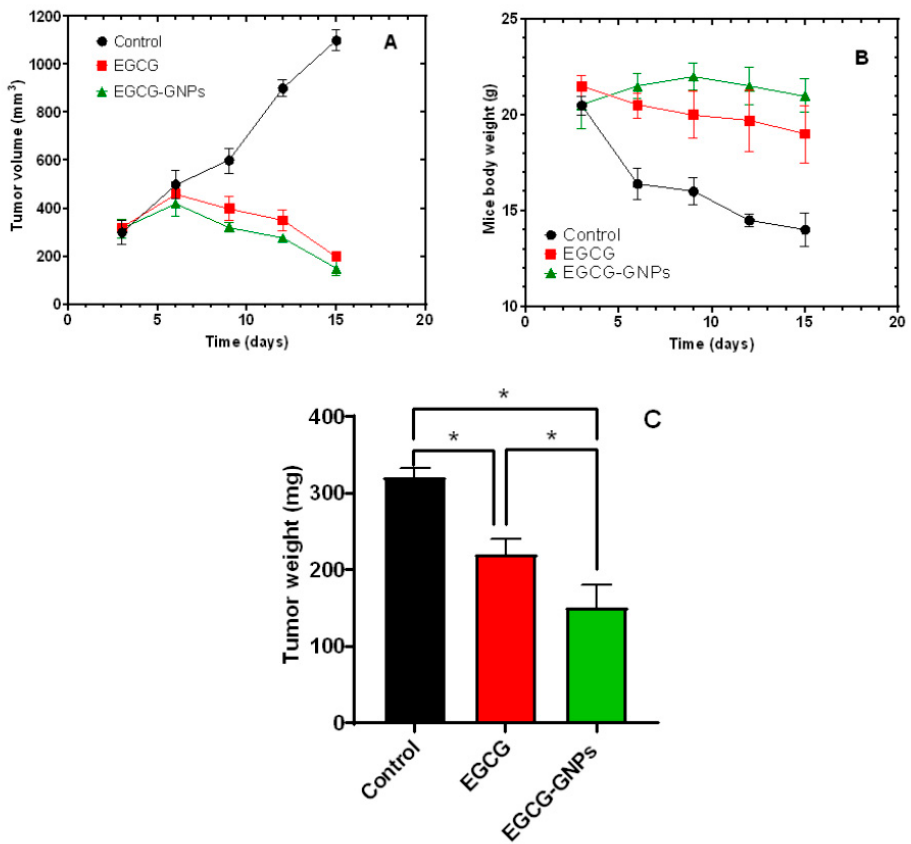
Figure 9. ( A ) Ehrlich ascites carcinoma growth curve. ( B ) Changes in the body weight of the Ehrlich tumor-bearing mice as a function of time. ( C ) Weight of the tumor at the end of the study. * Statistically significant difference ( p < 0.05). The observed results confirm that loading of EGCG onto GNPs resulted in significant enhancement of its anticancer efficacy.